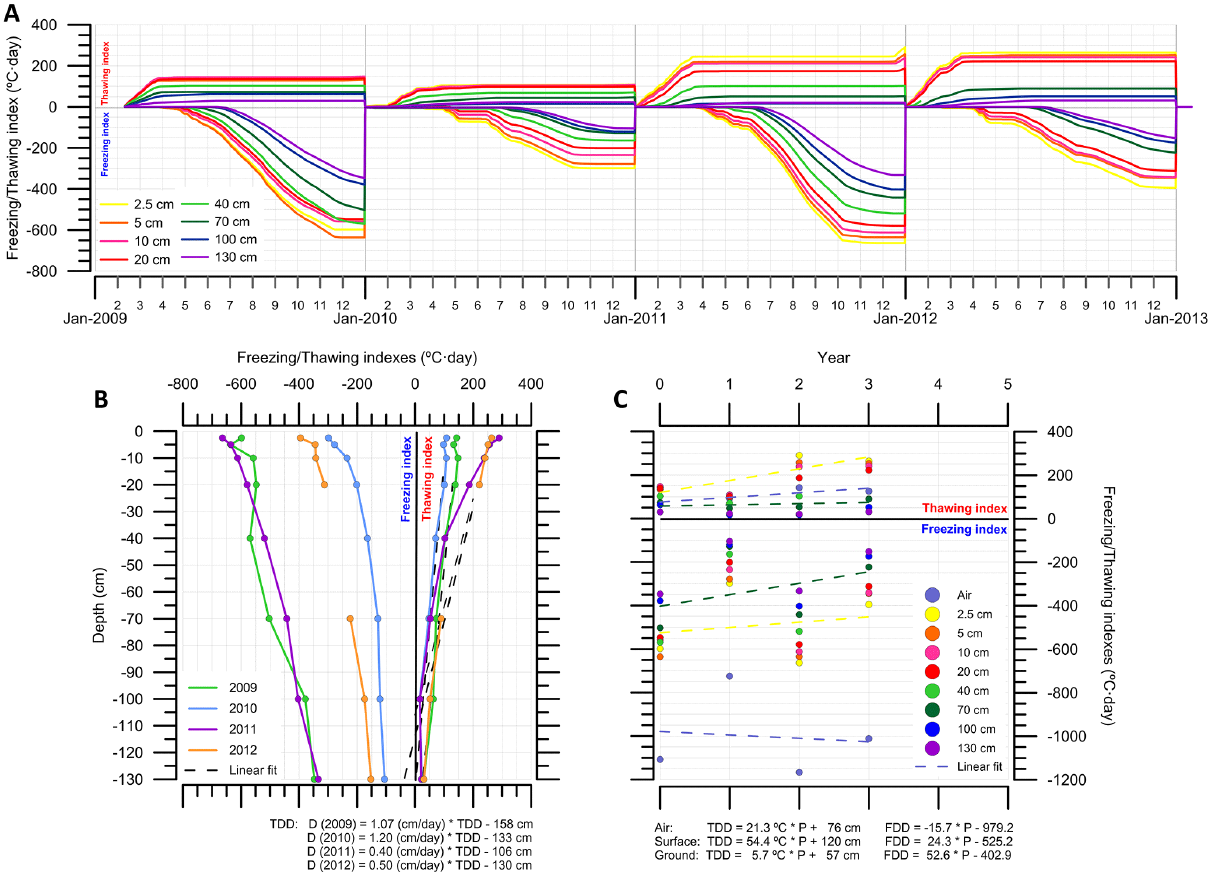
Figure 8. (A) Annual accumulated FDD and TDD indexes for the ground at different depths. (B) FDD and TDD evolution in the study period with linear fitting curves for the air, surface and 70cm depth. FDD and TDD profiles (C) allow for the deduction of a negative balance for each year, and linear fitting to TDD allows for the deduction of the theoretical depth with null thawing, i.e., the depth of the top of the